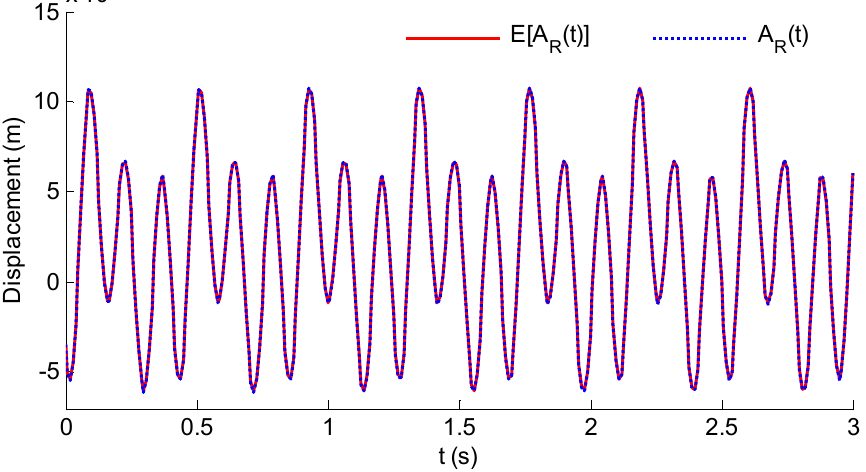
Figure 6. Displacement of the structure with σ ψ = 0.02, σ δ = 0.002, and σ ψ = 0.002. In order to appreciate the effect of the two reduction factors, the values of the following term is evaluated,